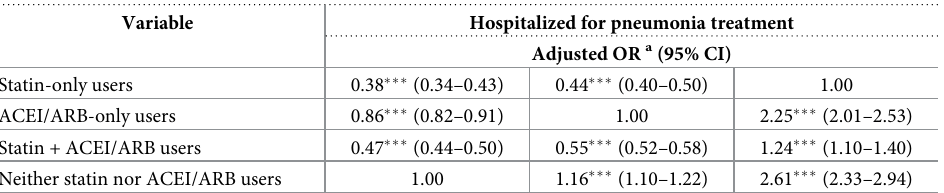
Table 3. Covariate-adjusted odds ratios (ORs) and 95% confidence intervals (CIs) for pneumonia among sampled patients (N = 38,562).